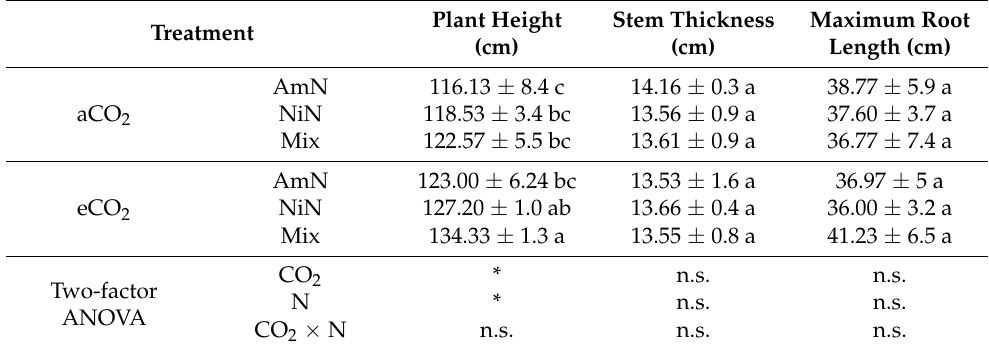
Table 3. Agronomic traits for maize growing.